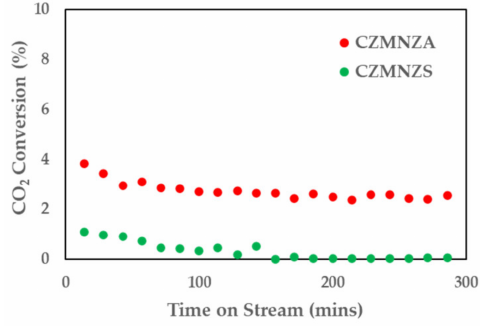
Figure 15. TOS of CO 2 conversion at reduction temperature 250 ◦ C.